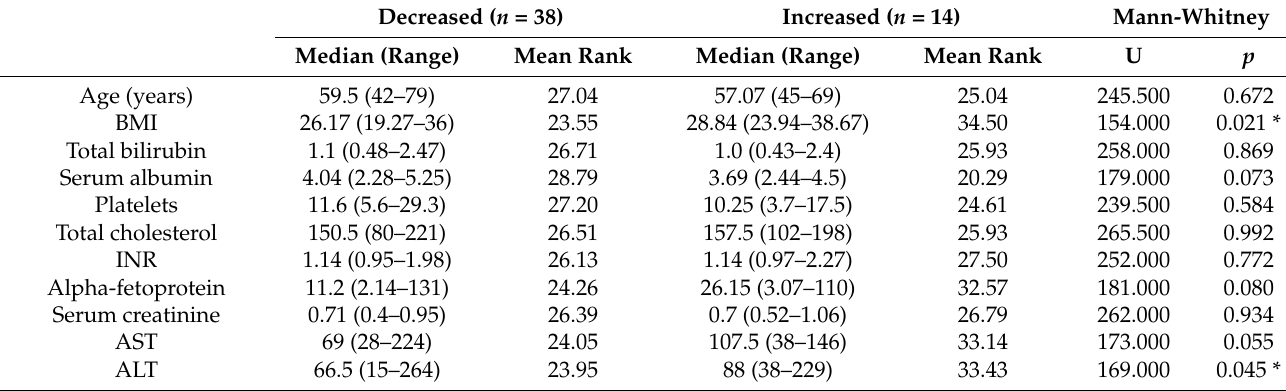
Table 3. Comparison between patients with decreased L3-SMI and increased